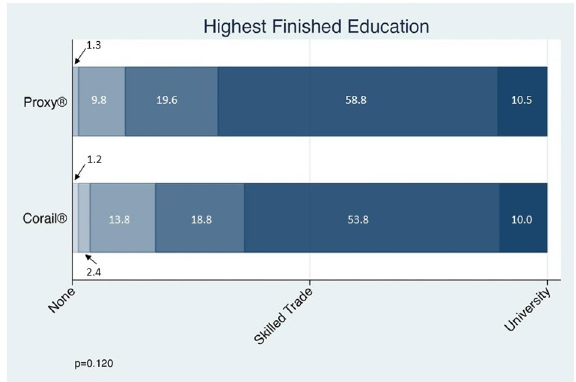
Figure 2. Highest finished education by study